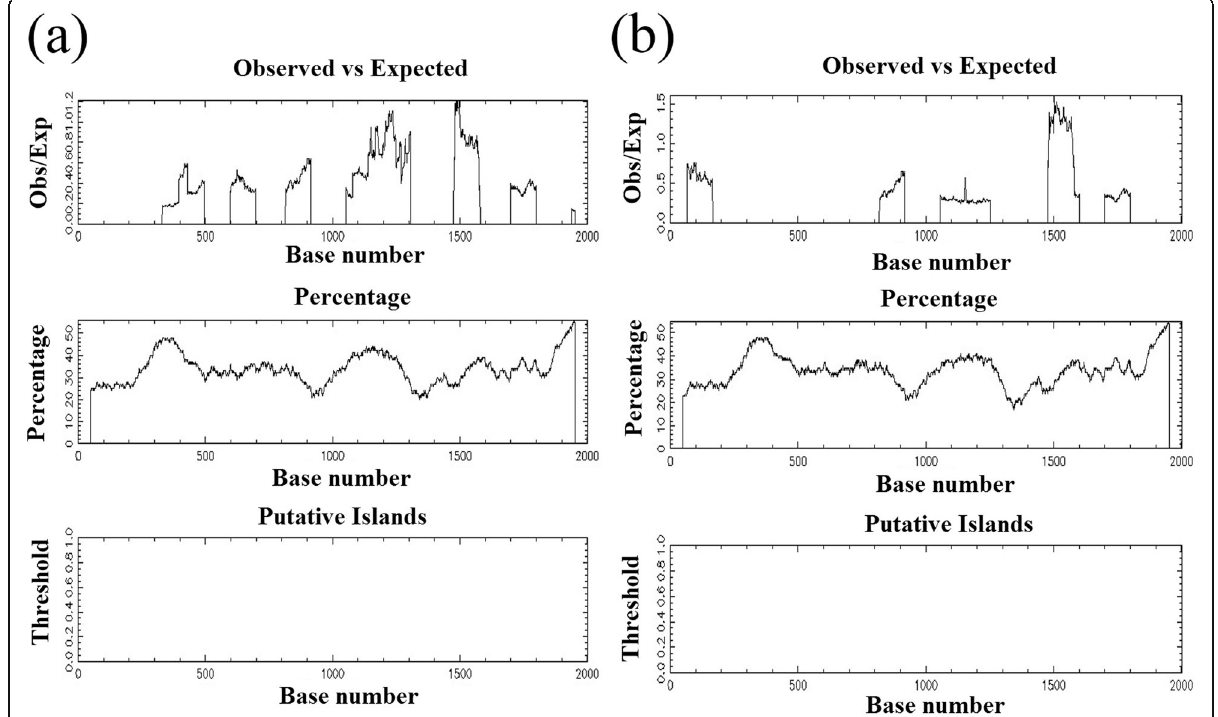
Fig. 3 a Cow sequence length 3.0kb, CpG island prediction result, no CpG island was found, criteria used: island size > 100, GC percent greater > 50.0, Obs/Exp > 0.6. b Buffalo sequence length 3.0kb, CpG island prediction result, no CpG island were found, criteria used: island size > 100, GC percent greater > 50.0, Obs/Exp >